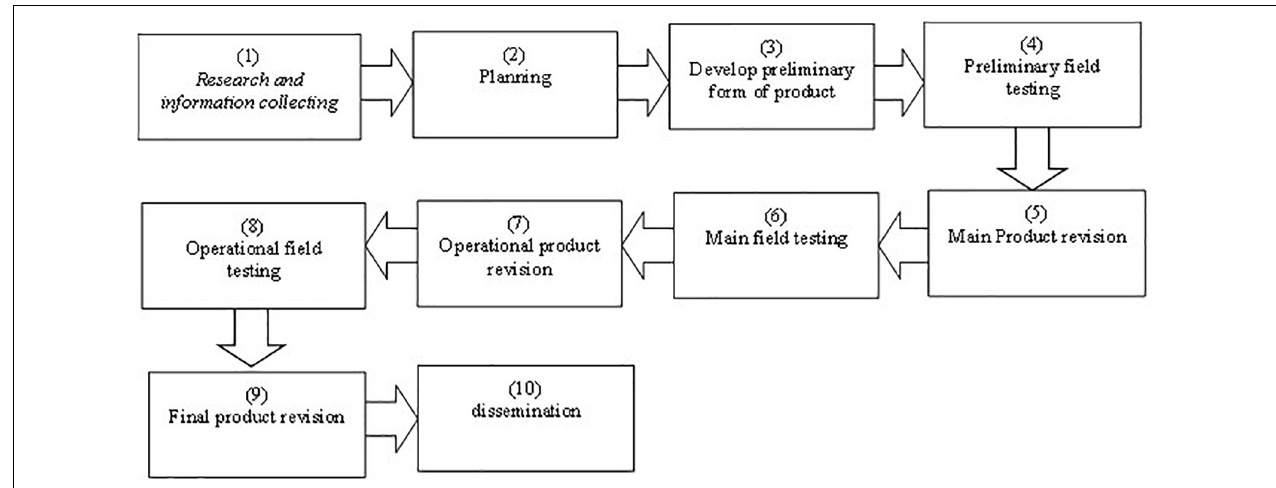
FIGURE 1 | Research and development models.